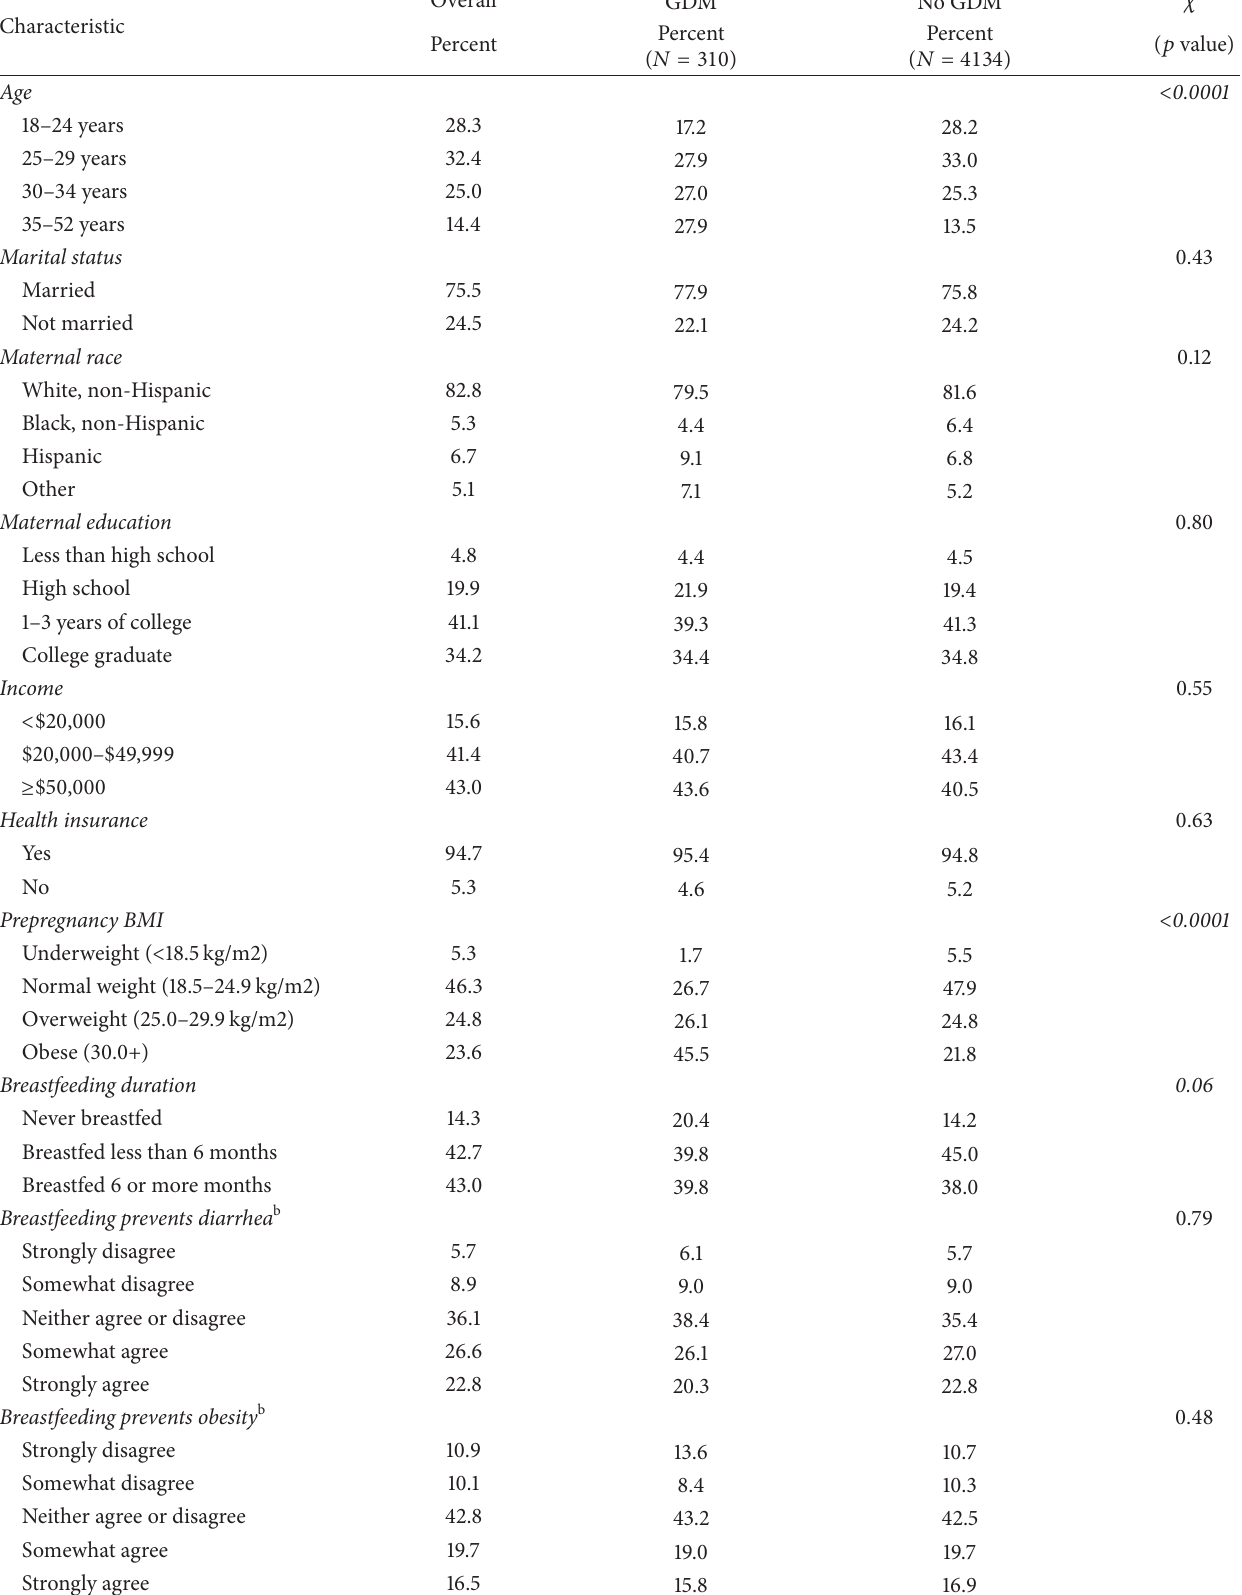
Table 1: Distribution of maternal characteristics by study population and gestational diabetes mellitus a